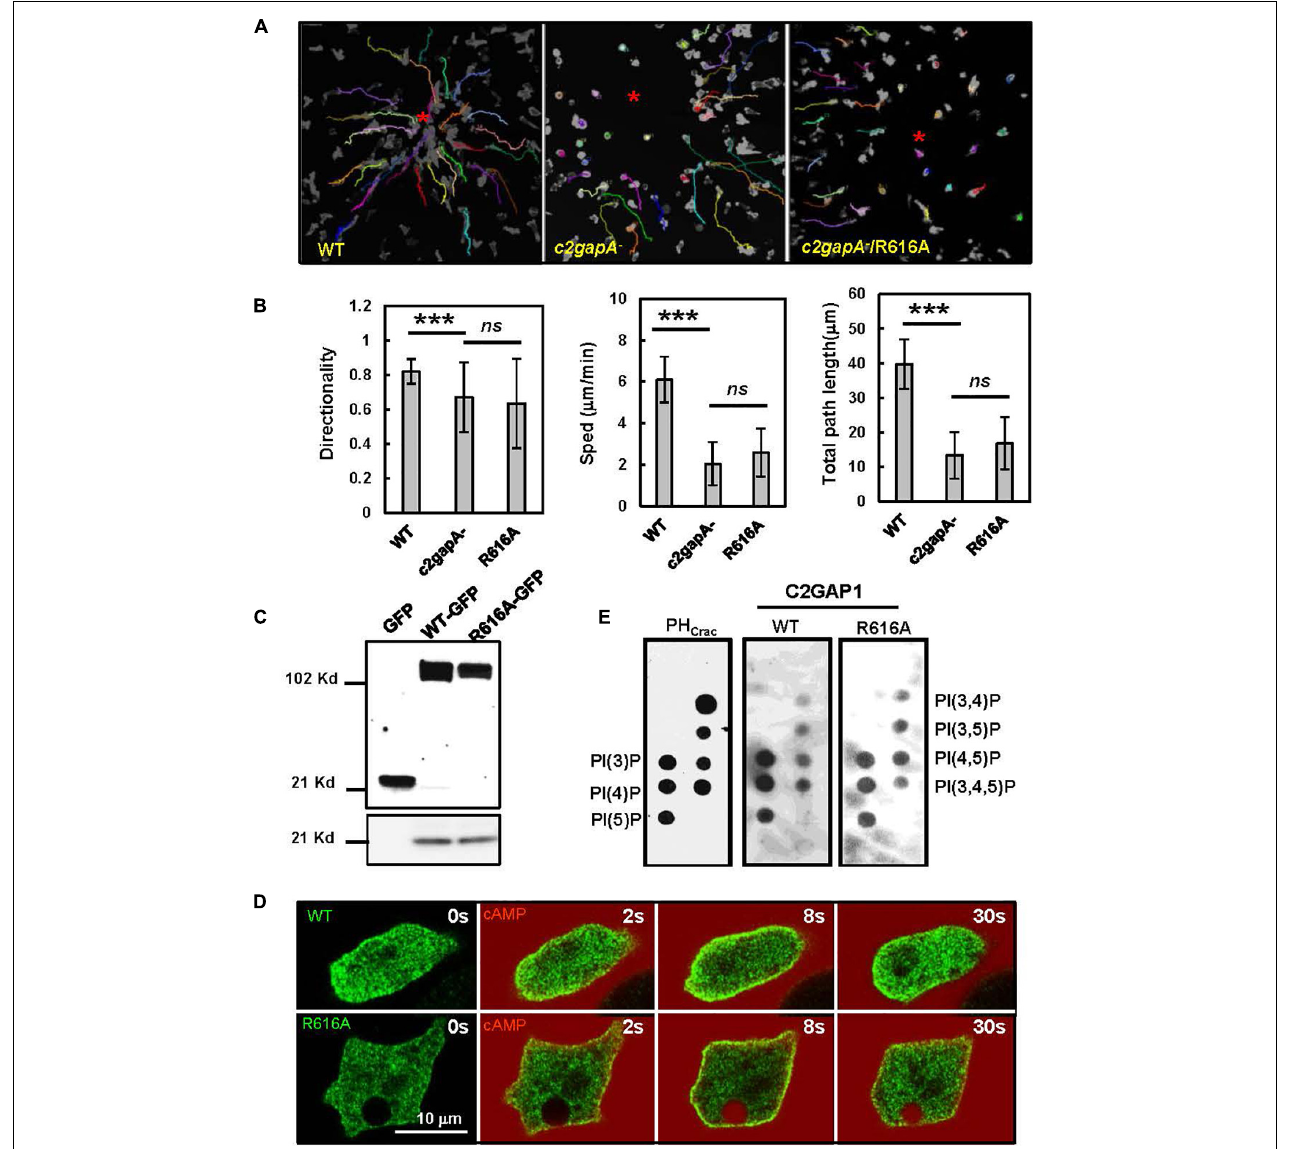
FIGURE 2 | GAP activity is not required for the binding of C2GAP1 and phospholipids on the plasma membrane. (A) Montage show the tracing paths of chemotaxing cells of WT or c2gapA − cells expressing empty vector ( c2gapA − ), or R616R ( c2gapA /R616A) mutant of C2GAP1. Red dots indicate the source of the cAMP gradients (10 µ M). (B) Quantitative measurements of chemotaxis parameters such as directionality, speed, and total path length using FIJI(NIH) with the MTrackJ plugin. Directionality, where 0 represents random movement and 1 represents straight movement toward the source of a gradient; speed, defined as the distance that the centroid of the cell moves as a function of time; total path length, the total distance the cell has traveled. 30 cells were traced in each group were measured for 5 min in each group. Mean ± SD is shown. The p- values of Student’s t -test are indicated as ns (not significant, p > 0.05) and *** ( p < 0.001). (C) Interaction between WT or R616A mutant of C2GAP1 and Ras determined by co-IP. Lysates of cells expressing GFP or GFP-tagged WT (WT-GFP) or R616A (R616A-GFP) of C2GAP1 were incubated with agarose beads conjugated with anti-GFP antibodies and then subjected to immunoprecipitation and western blot detection of GFP and Ras using their specific antibodies. (D) cAMP stimulation triggers membrane translocation of WT or R616A mutant of C2GAP1 in the cells. Cells expressing GFP-tagged WT or R616A (green) were stimulated with 10 µ M cAMP. The application of cAMP was visualized by mixing cAMP with a fluorescent dye, Alexa 594 (red). Also see Supplementary Video 2 . (E) Phospholipid binding of WT or R616A mutant of C2GAP1. Lysates of cells expressing either PH Crac -GFP, WT-GFP, or R616A-GFP were incubated with PIP strips and then subjected to western blot detection by anti-GFP. The western blotting of three PIP-strip membranes were performed using the same procedures.